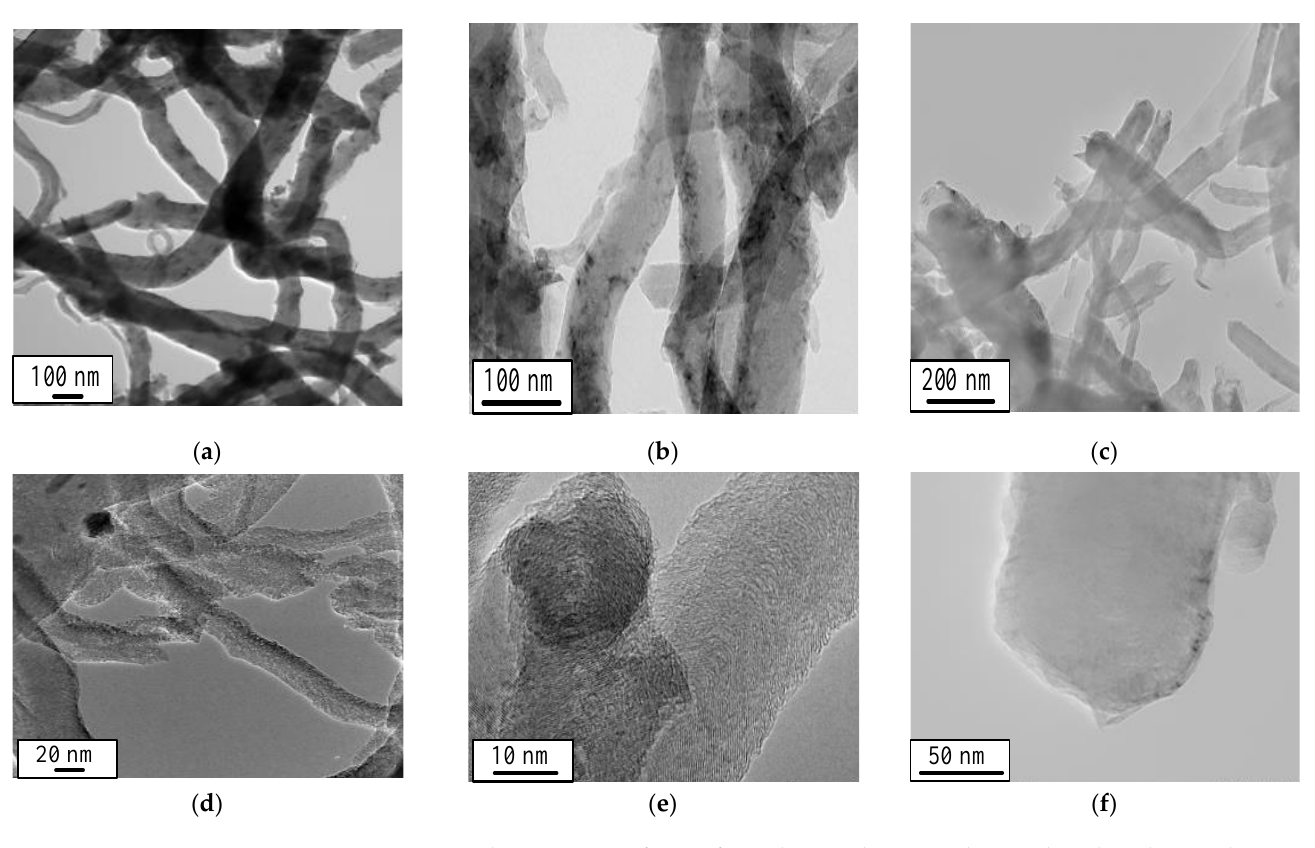
Figure 7. Typical TEM images of CNFs formed over solution combustion-based catalysts and var- ious fuels: ( a , d ) HMTA; ( b , e ) glycine; ( c , f ) oxalic